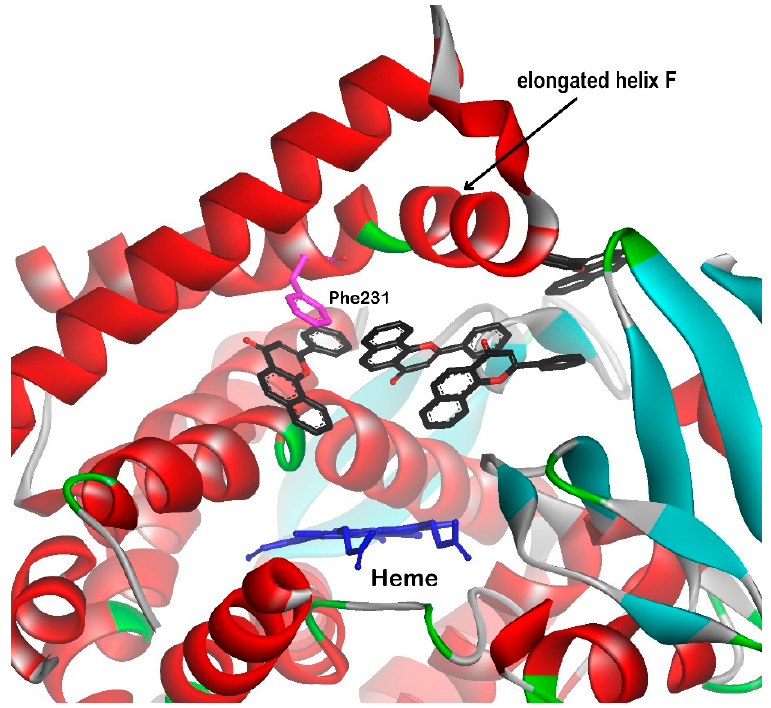
Figure 5. Four molecules of ANF bound to ancestral CYP1B1 (PDB id: 6OYU). ANF (black carbon atoms), heme (dark blue), and Phe231 (magenta) presented as stick models.